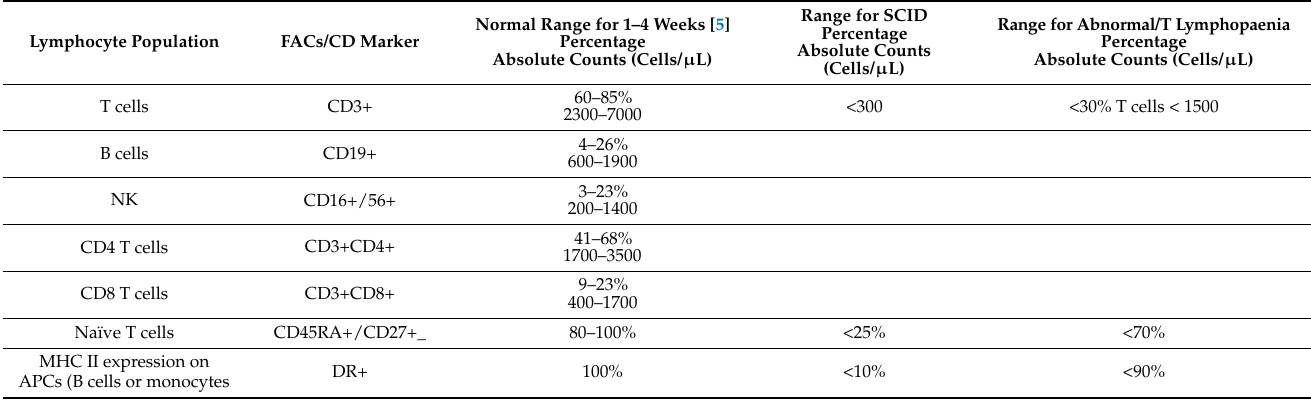
Table 1. Summary of lymphocyte subsets listing common name, CD/FACs markers, a normal range for infants 1 week to 4 weeks of age, values for defining SCID and abnormal (T